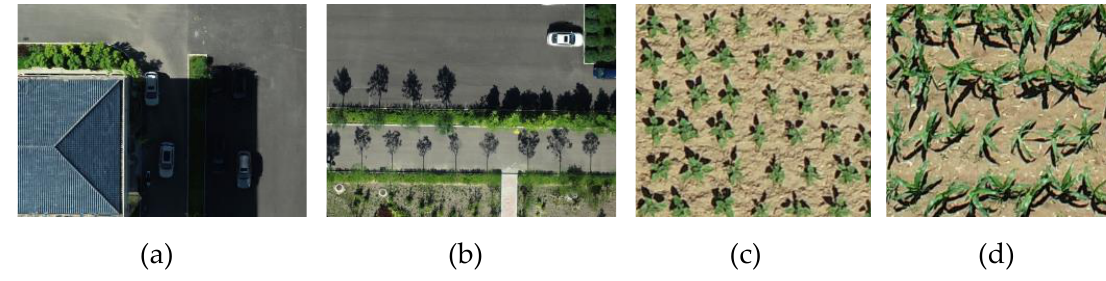
Remote Sens. 2022 , 14 , x FOR PEER REVIEW